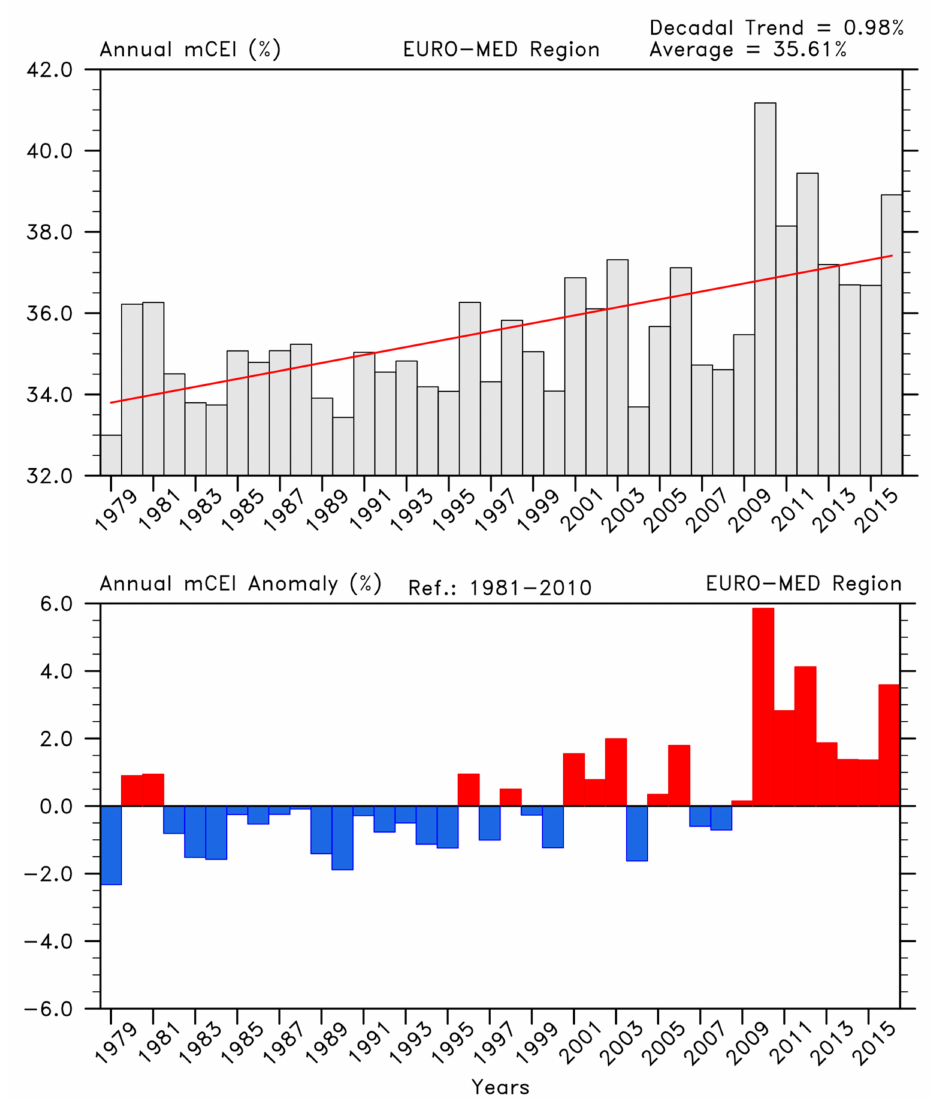
Figure 9. Spatially-average of mCEI ( upper ) and annual anomalies ( bottom ) over the EURO–MED region. In order to better illustrate how mCEI captures anomalous conditions, we performed snapshot analyses for 2003 and 2010. In the summer of 2003, Europe was affected by a heatwave, which was over the records [51,52]. A persistent ridge–trough couplet centred in the eastern Atlantic resulted in an atmospheric blocking and caused a heatwave over Scandinavia, which was followed by a Central European heatwave due to very weak synoptic-scale pressure gradients and winds [53]. Figure 10 shows 10 extreme indexes, the annual mean and the anomaly of mCEI for 2003. In this year, extreme daytime tempera- tures (TX90P) have a local hotspot between 45 ◦ N and 50 ◦ N latitudes (Figure 6). Warm extremes are greater than 20% over Central and Western Europe, and the annual intensity of extreme drought is greater than 50% over the north of Scandinavia and Central Europe. The extreme precipitation rate is, locally, greater than 44% over western Russia and the Mediterranean coasts. Extreme moist conditions are prominent over the southwest of Turkey, Greece, and Bulgaria. All of the extreme indexes are combined, and, consequently, the EURO–MED region averaged mCEI is calculated as 37.32% with a positive anomaly of 2.09%. The anomaly reaches up to 15% over Northern and Central Europe and the Mediterranean